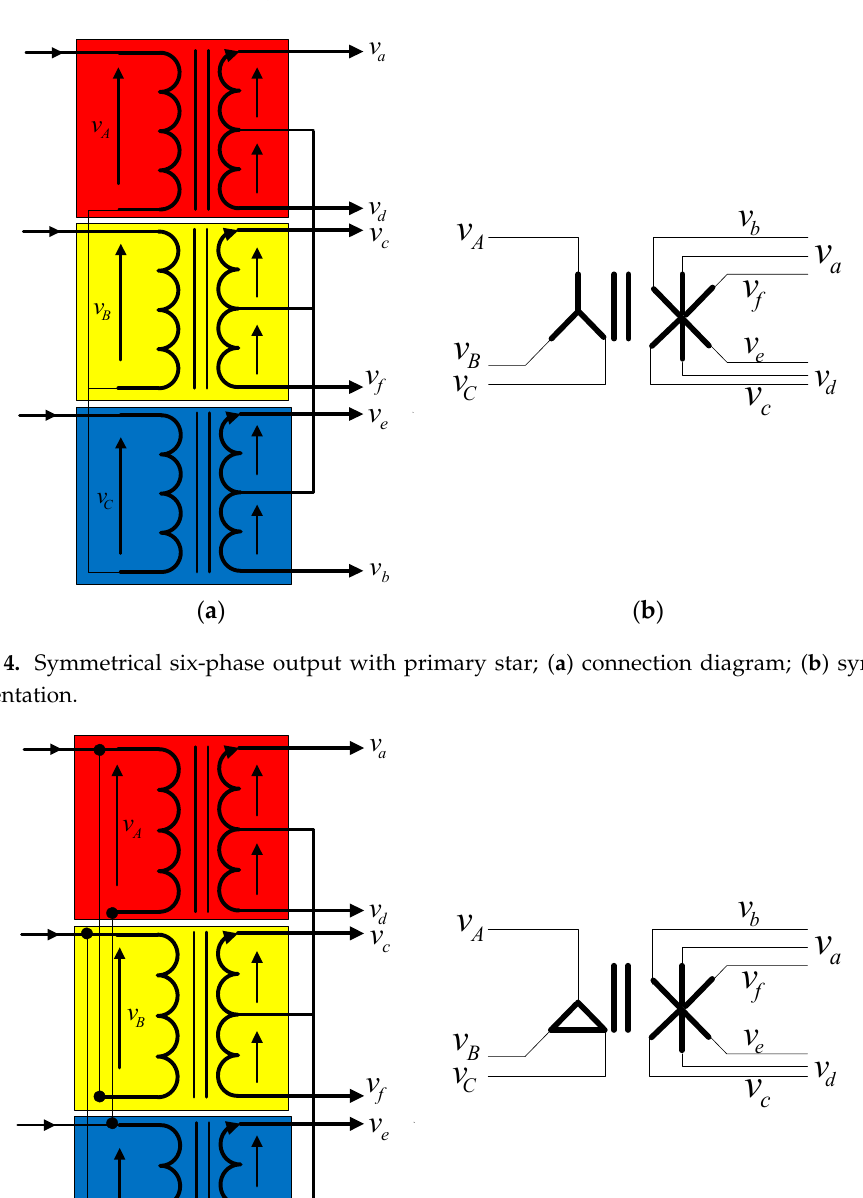
Figure 5. Six-phase output with primary delta; ( a ) connection diagram; ( b ) symbolic representation.